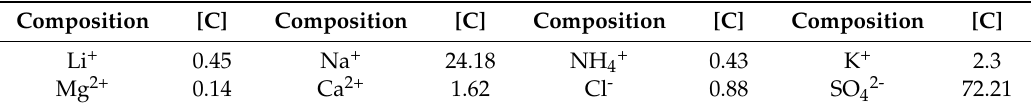
Table 4. Ion concentration [C] of condensate water (mg/L).